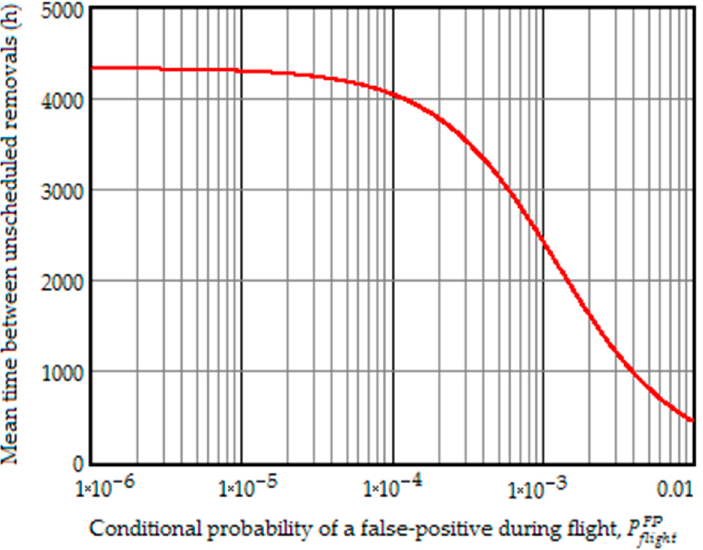
Figure 1. The dependency of MTBUR on the conditional probability of false-positive during flight.